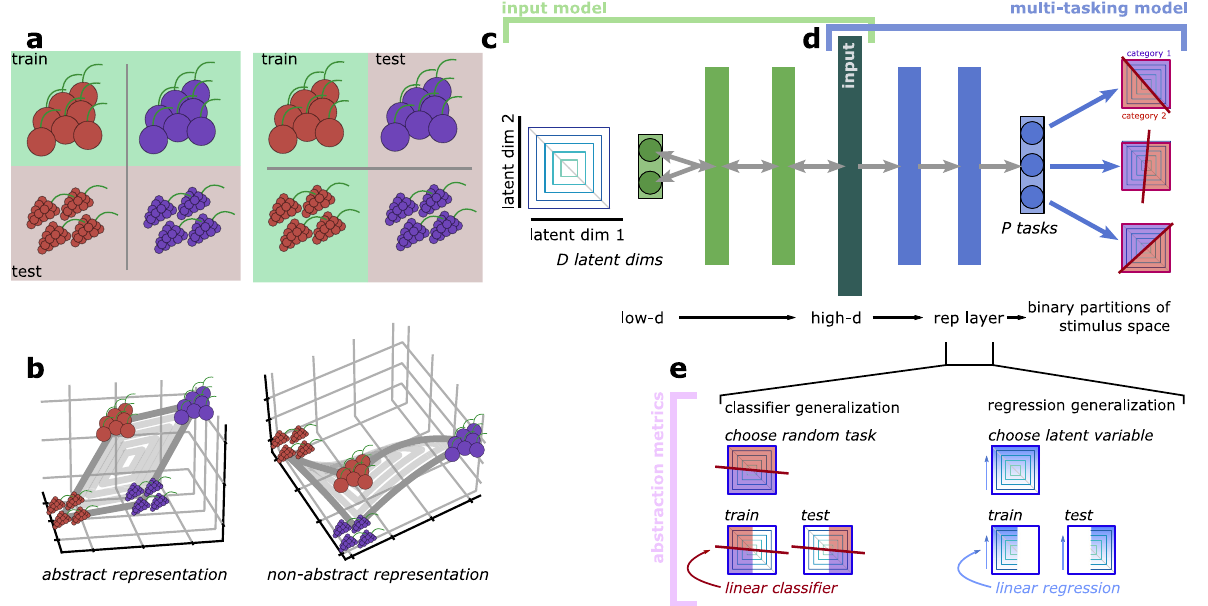
Fig. 1 | The abstraction metrics and input representations. a Two example classi fi cation tasks. (left) A classi fi cation learned between red and blue berries of one shape should generalize to other shapes. (right) A classi fi cation between red berriesoftwodifferentshapesshouldgeneralizetoblueberriesofdifferentshapes. b Examples of linear, abstract (left), and nonlinear, non-abstract (right)